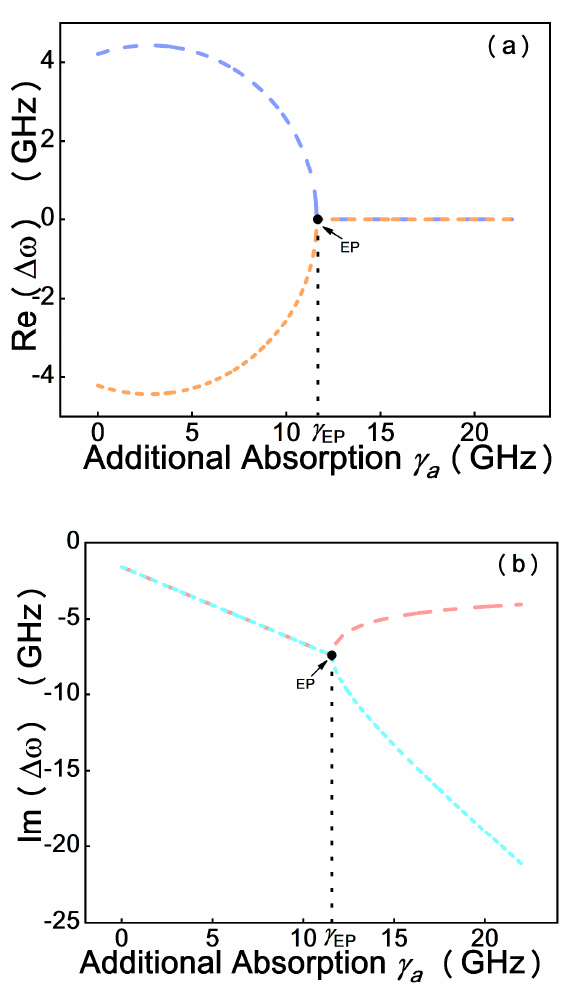
Figure 5. The real (Re ( ∆ ω ) , ( a )) and imaginary (Im ( ∆ ω ) , ( b )) parts of the eigenvalues vary with the increase in additional absorption of the sensing cavity.